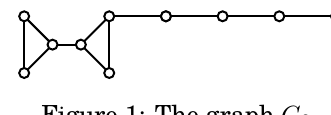
Figure 1: The graph G 9